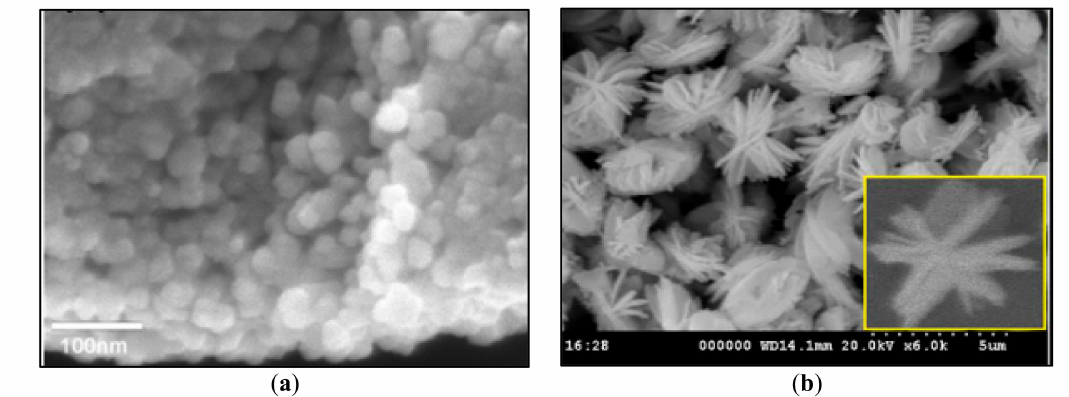
Figure 14. SEM images of ( a ) Bi 2 Mo 3 O 12 photocatalyst [95] ( b ) uniformly size and shape of Nd 2 Mo 3 O 9